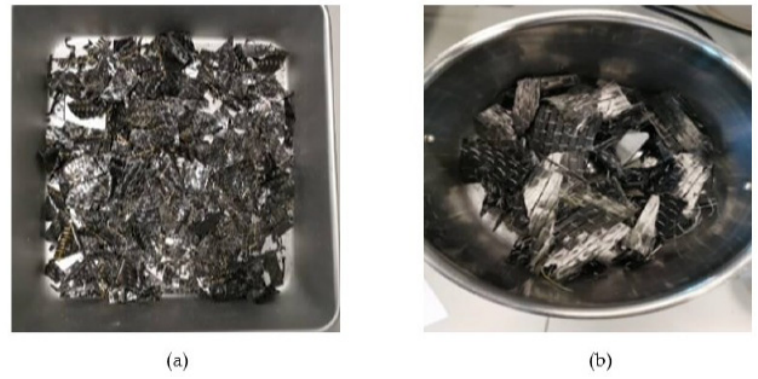
Figure 5. Samples after the cutting ( a ) CFRP, ( b ) CF.